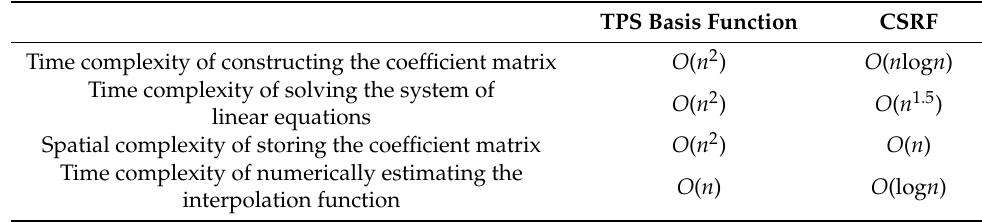
Table 2. Comparison of the computational